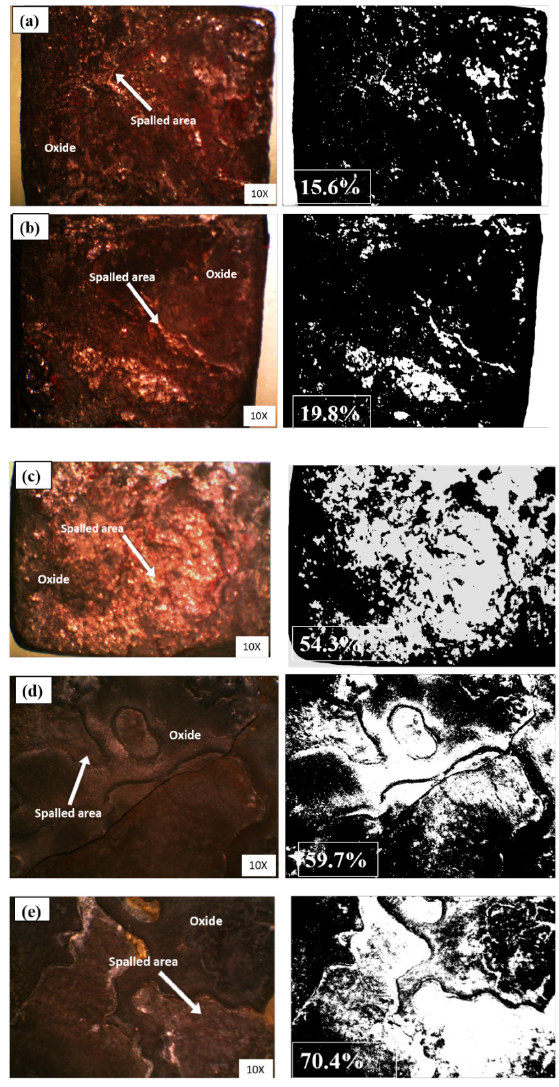
Figure 10. The oxide morphologies using a stereoscope at 50X ( a ) at 700 °C, ( b ) 800 °C, ( c ) 900 °C, ( d ) 1000 °C, and ( e ) 1100 °C. The left column of the images indicates the real-time oxides captured using stereo microscopy, while the right side shows the phase fraction images taken to understand the spallation resistance of the samples.